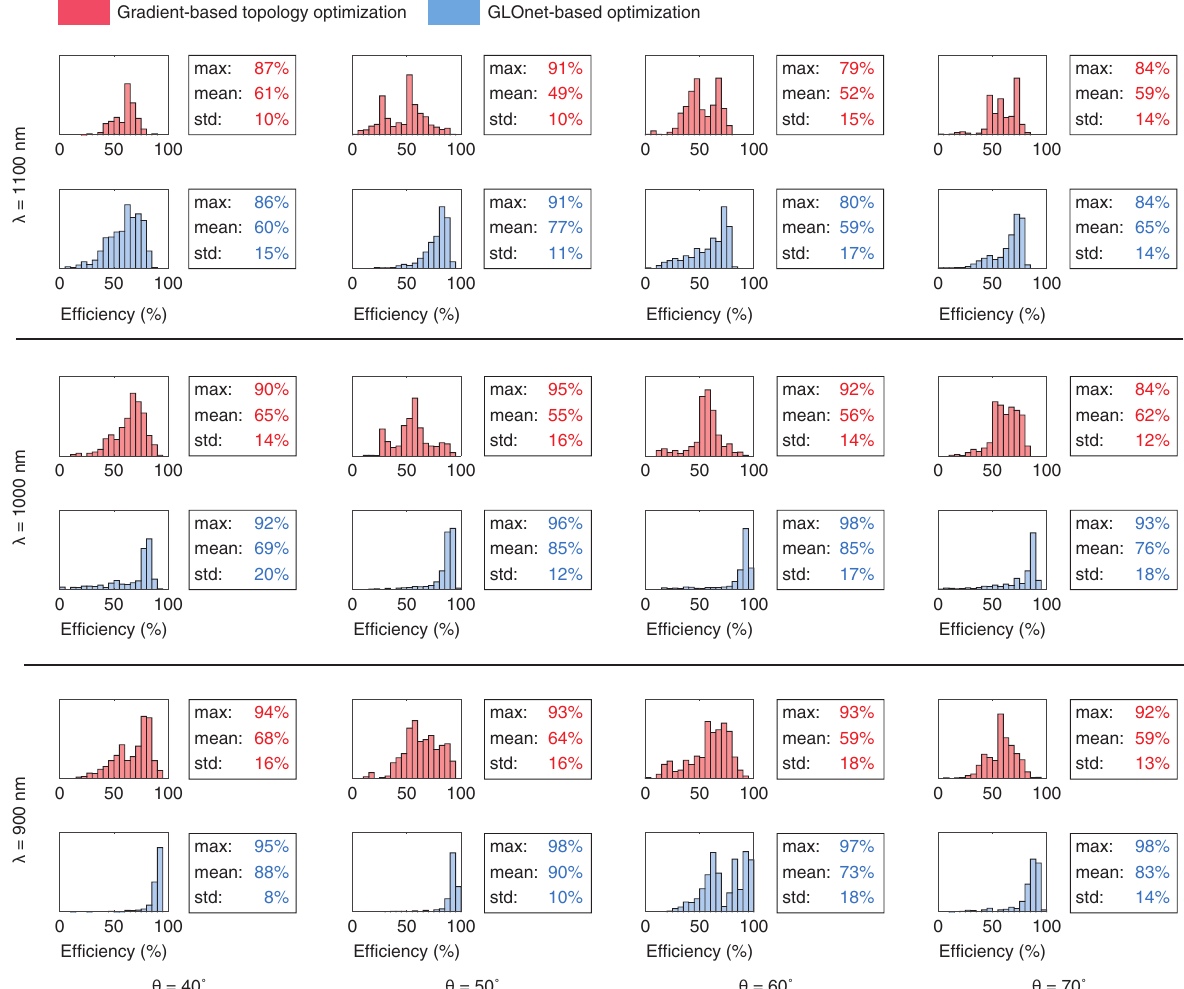
Figure 5: Efficiency histograms of 500 devices designed using gradient-based topology optimization (red) and GLOnet-based optimization